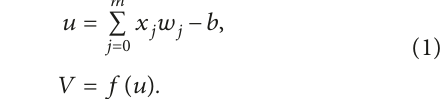
j represents the weight for